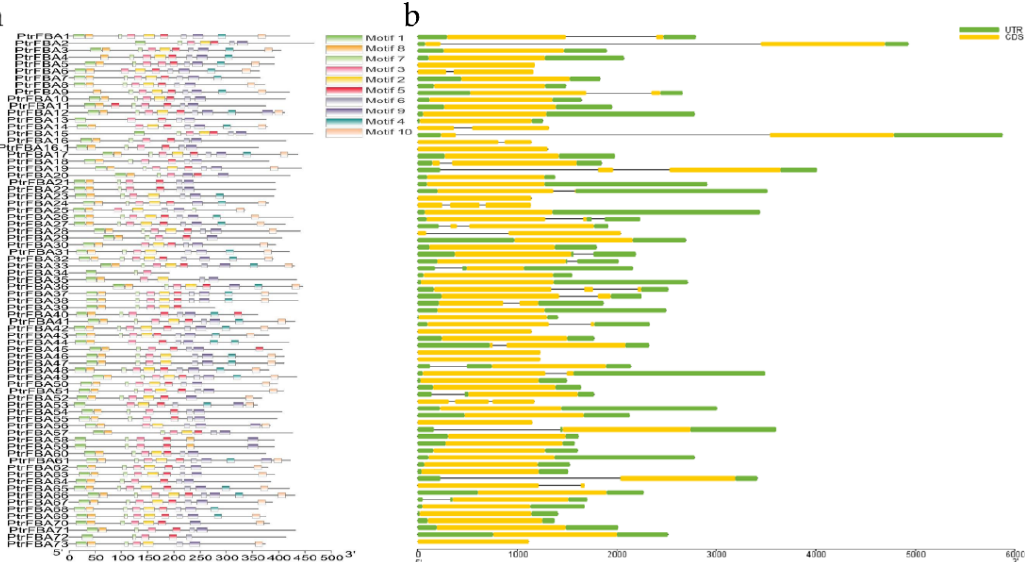
Figure 6. Conserved protein structure and gene structure analysis of the PtrFBA gene family of P. trichocarpa. ( a ) Motif analysis of the PtrFBA gene family of P. trichocarpa . Individual motifs are displayed in square blocks of different colors, and the type is numbered on the square blocks. ( b ) Gene structure analysis of the PtrFBA gene family of P. trichocarpa. Upstream and downstream non-coding regions are indicated by green rounded rectangles, exons are indicated by yellow rounded rectangles, and introns are indicated by gray